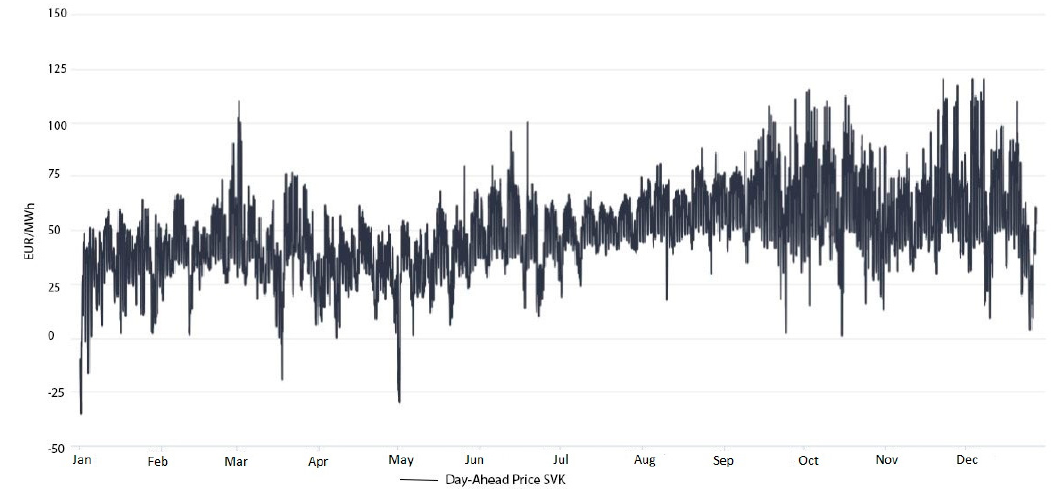
Figure 7. Electricity spot prices in 2018 (Source: [33]).